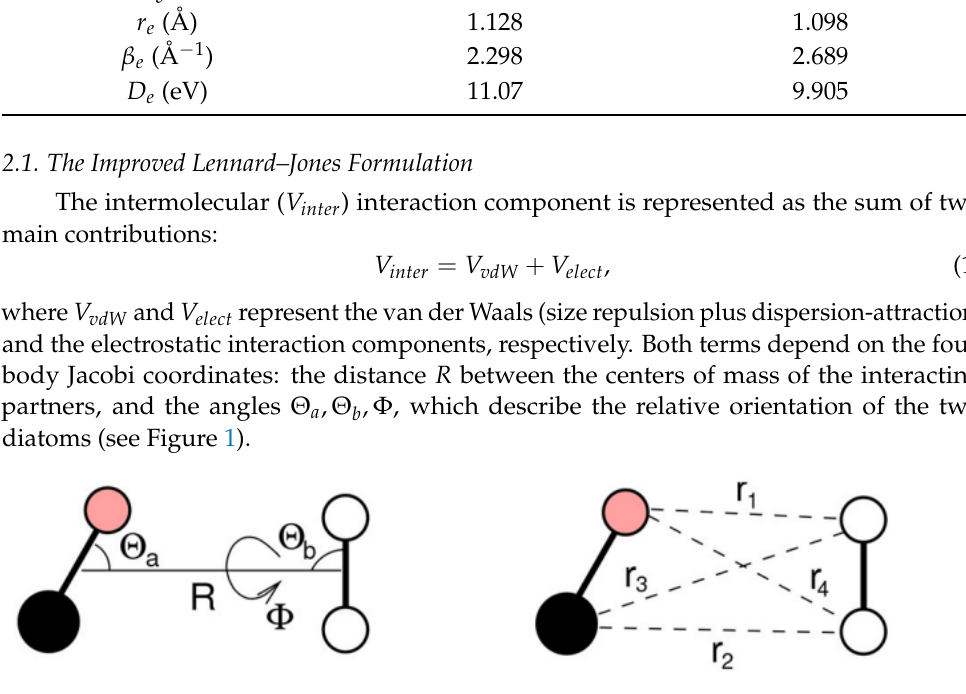
Figure 1. Schematic diagram of CO-N 2 dimer with the coordinates needed to define the intermolecu- lar interaction contributions in Equation